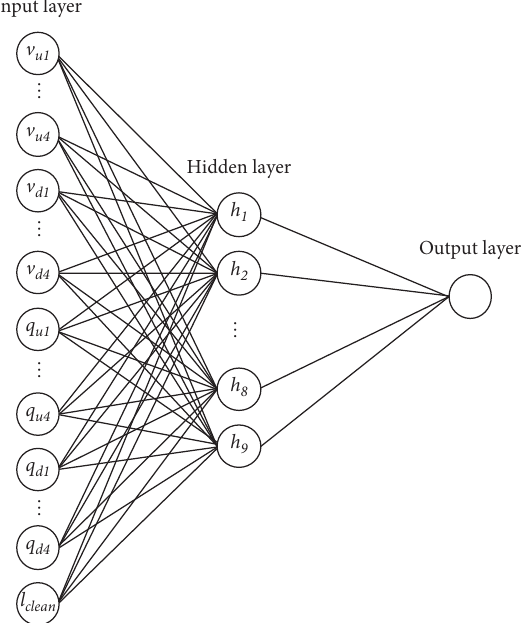
Figure 9: Structure of the BPNNs in the 4-lane model.